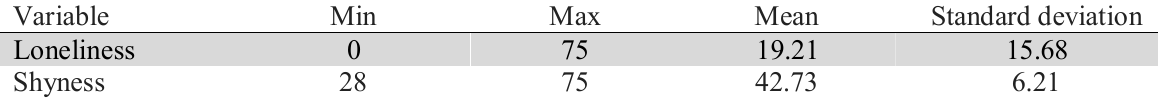
The summary of some basic statistics